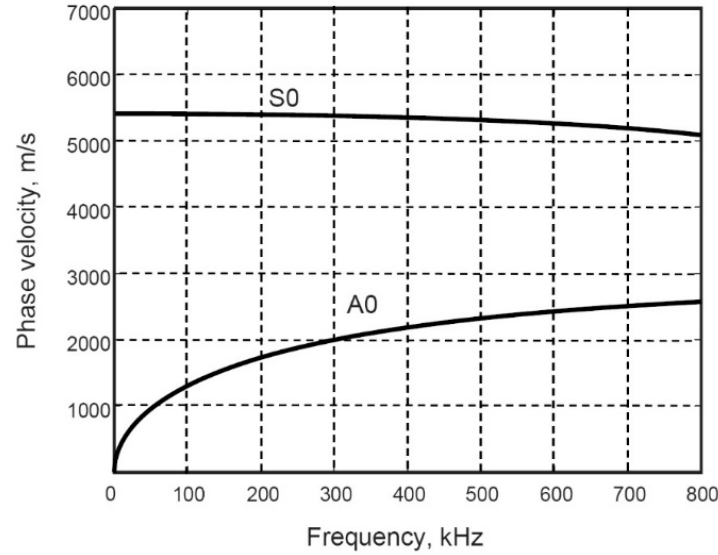
Figure 2. The phase-velocity dispersive curves of the A 0 and S 0 modes of Lamb waves calculated by using the analytical method (package ‘DISPERSE’).